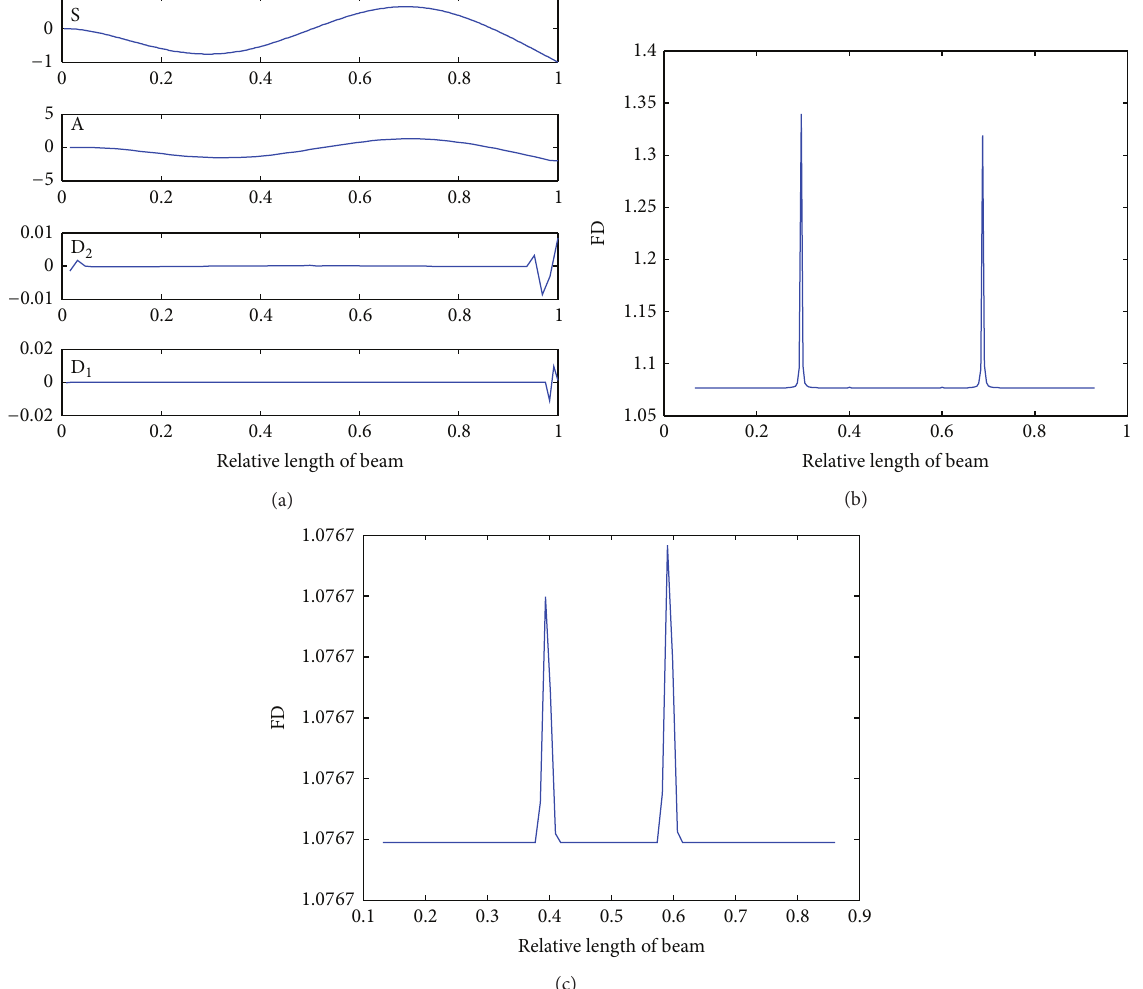
Figure 4: Crack location identification results using the proposed method for the third mode shape. (a) The third mode shape S and its wavelet decomposition at level 2. (b) FD of the detailed signal D 1 without linear mapping. (c) FD of the detailed signal D 1 by linear